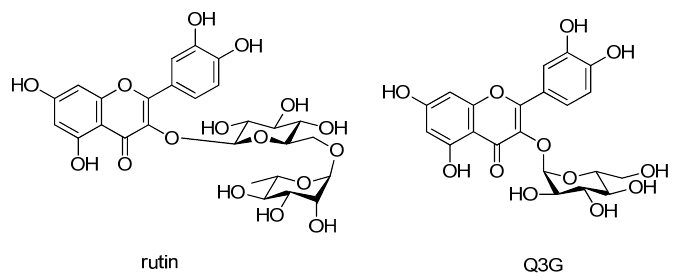
Figure 1. Chemical structures of rutin and quercetin-3- O - β - D -glucoside (Q3G)